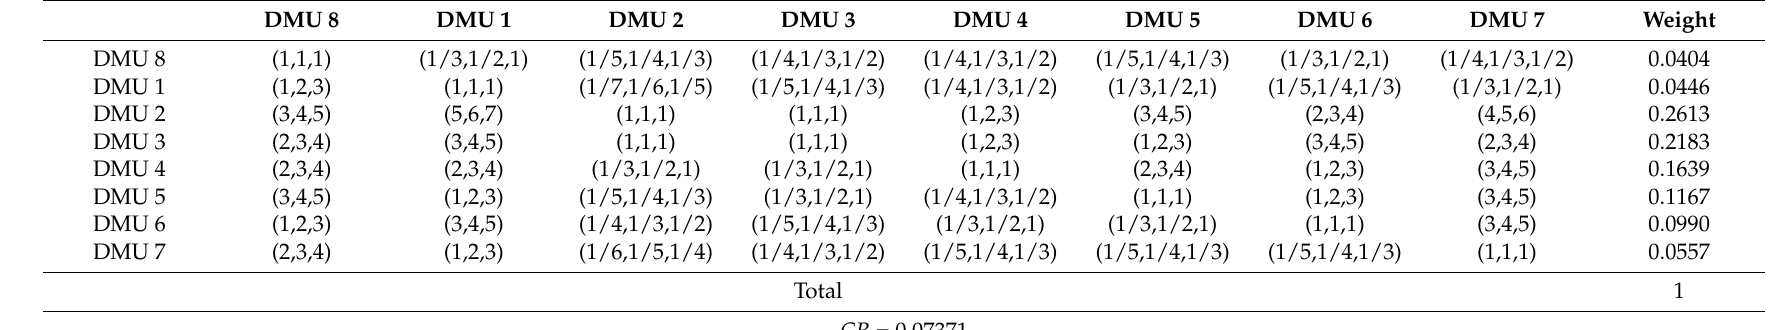
Table A33. Comparison matrix for SWQ based on